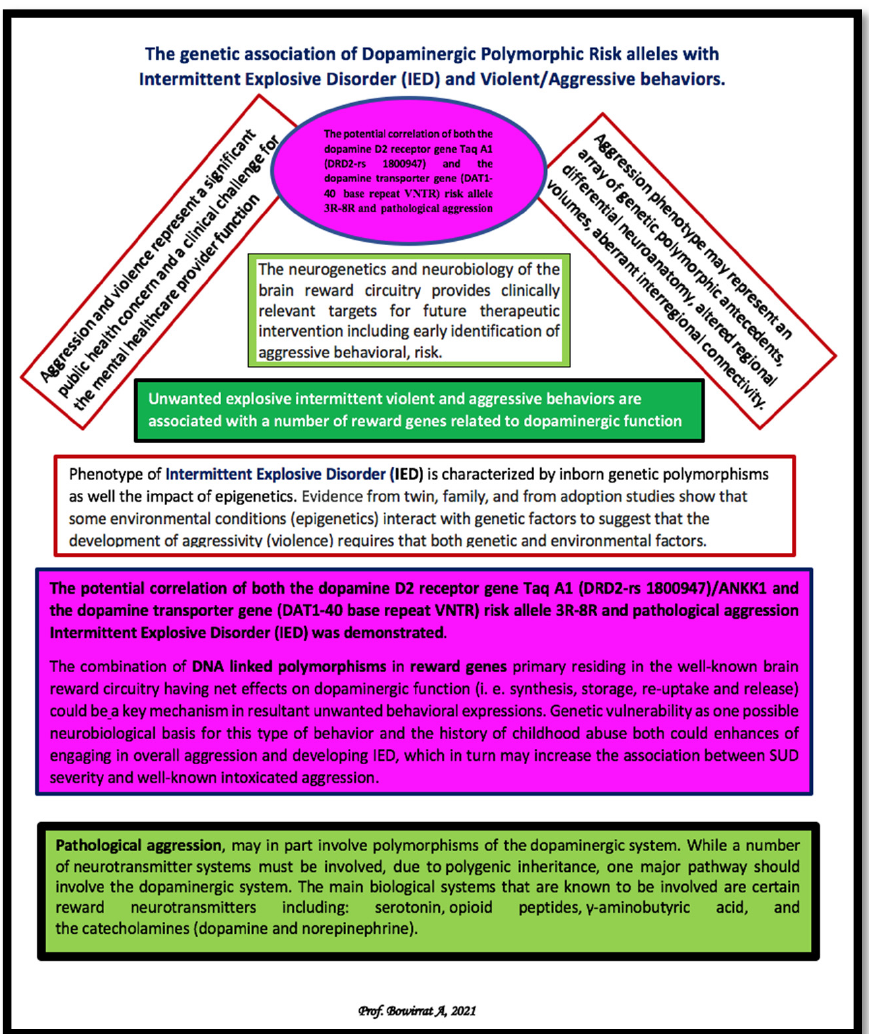
Figure 3. A schematic representing a summary of dopaminergic genetics with intermittent explosive disorder (IED), violent/aggressive behavior, and addiction.